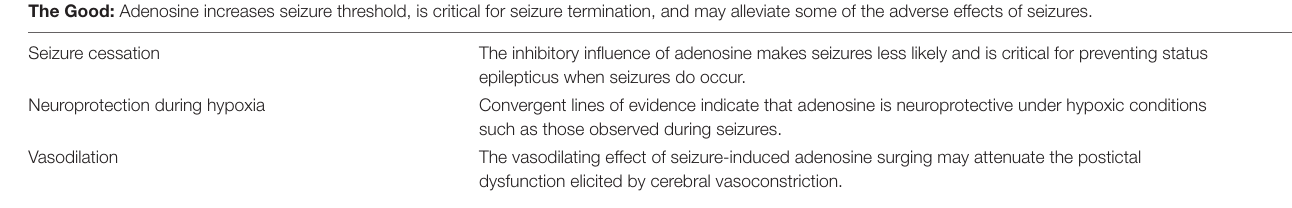
TABLE 1 | The beneficial effects of adenosine in the context of seizures and epilepsy. The Good: Adenosine increases seizure threshold, is critical for seizure termination, and may alleviate some of the adverse effects of seizures. Seizure